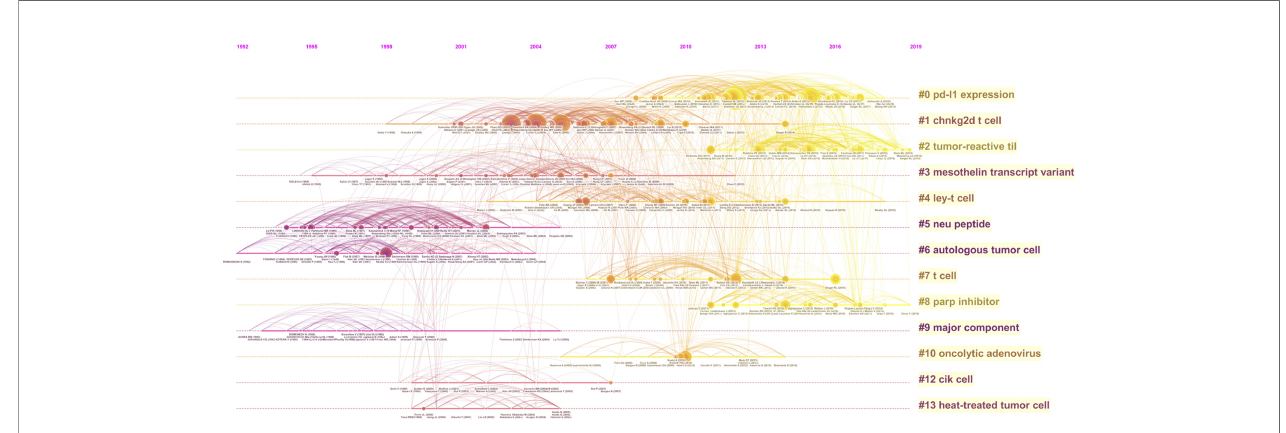
FIGURE 5 | A timeline visualization of the 14 clusters.